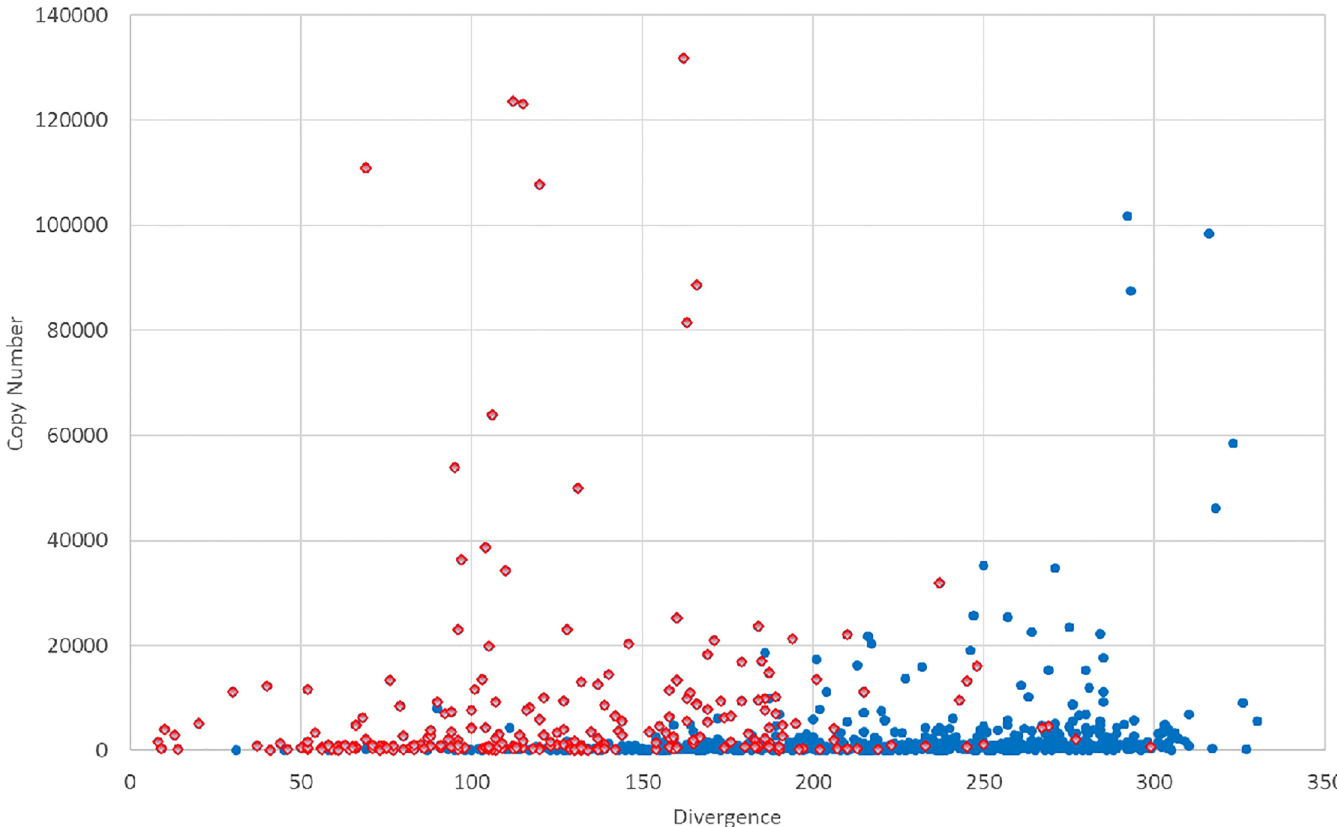
Fig 4. Hits of Repbase repeats found by REPdenovo. X axis: divergence rate (mismatches per 1,000 bases) of repeats given by Repbase. Y axis: number of copies from the UCSC genome browser annotation. Dots: Repbase repeats. Red dots: hits found by REPdenovo. Blue dots: repeats not found by REPdenovo.